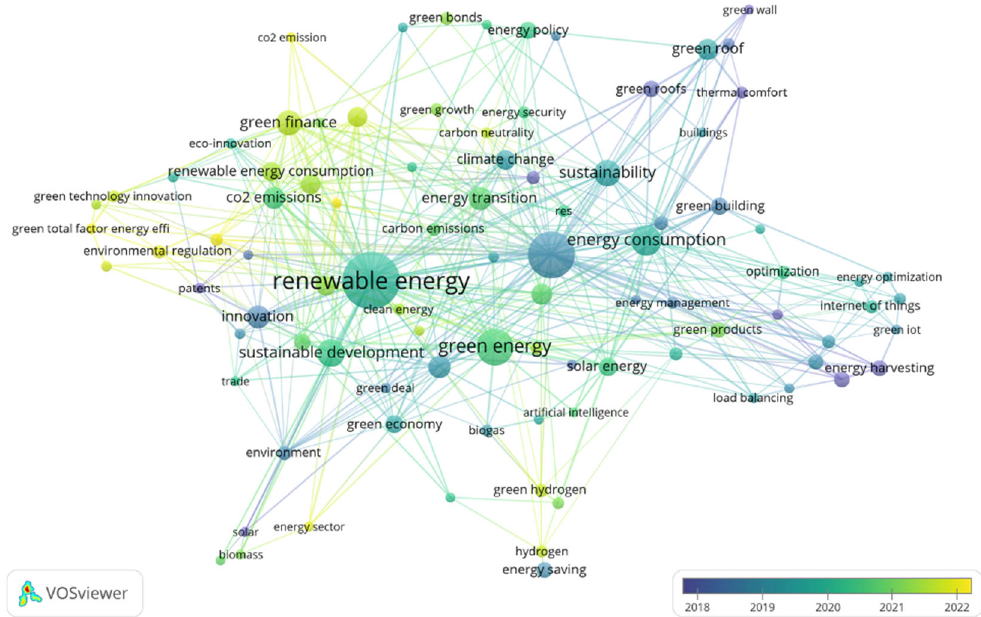
Figure 9. Co ‐ occurrence map (overlay visualization). Figure 9. Co-occurrence map (overlay